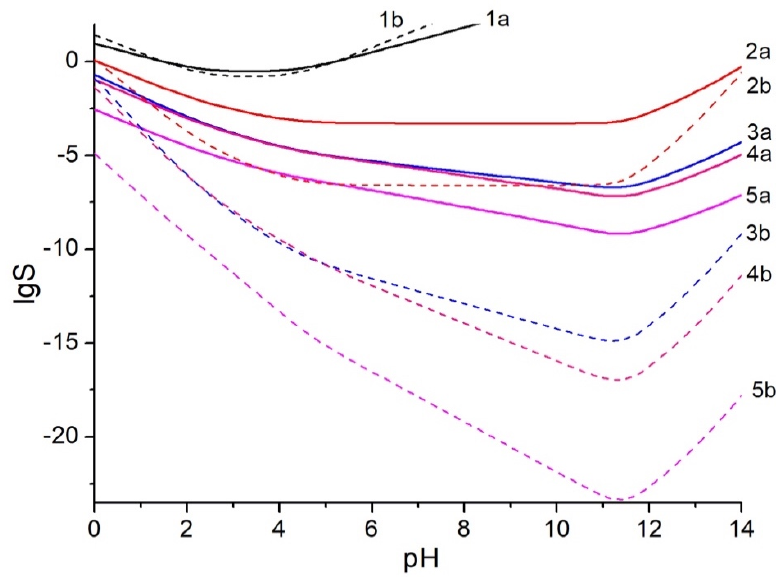
Figure 8. The solubility isothermal of the following precipitates: Ca(H 2 PO 4 ) 2 ·H 2 O (1a,